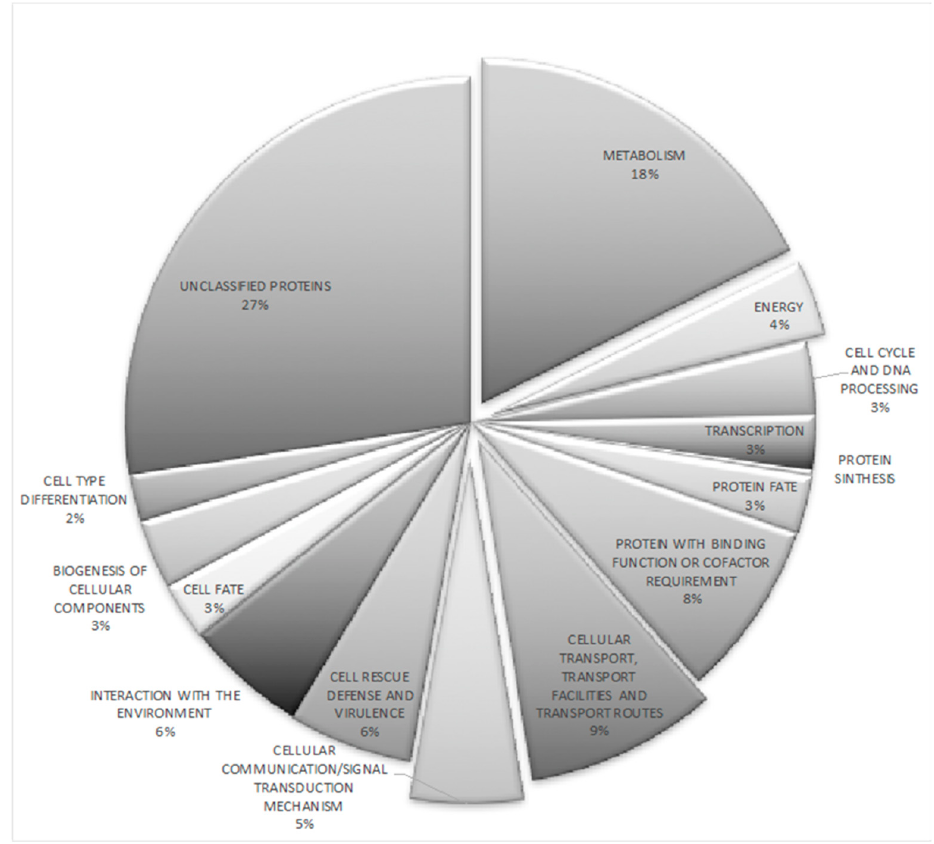
Figure 6. Functional categorization of the U. maydis 368 differentially regulated genes at pH 4 in the Δ nrg1 mutant strain. The figure shows the percentages of differentially regulated genes corresponding to each given functional category. http://mips.gsf.de/funcatDB/.